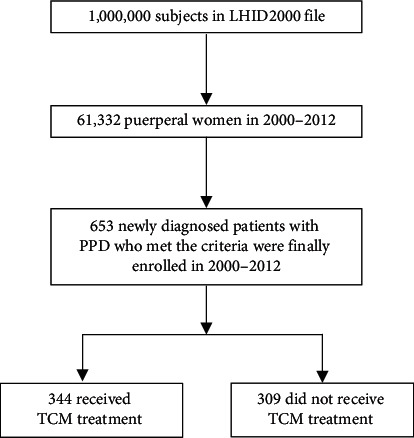
Flowchart for study subject enrolment. LHID2000: Longitudinal Health Insurance Database 2000. TCM: traditional Chinese medicine.